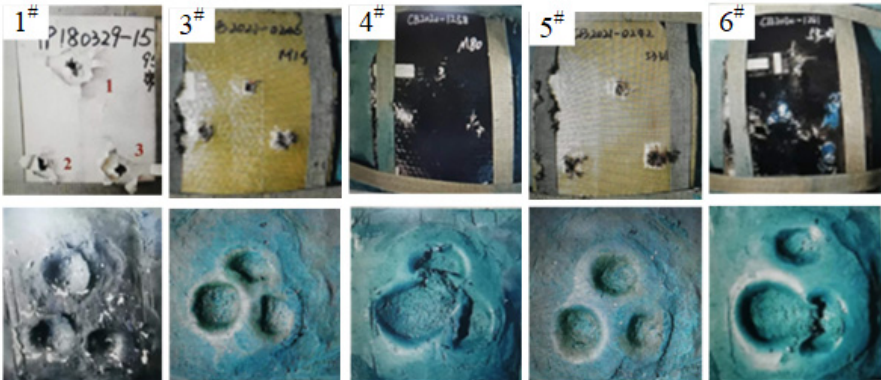
Table 3. Material parameters of the rotating band. Figure 6. Panel photos and the corresponding back convex photos of the rubber mud after the number-inserting board shooting.